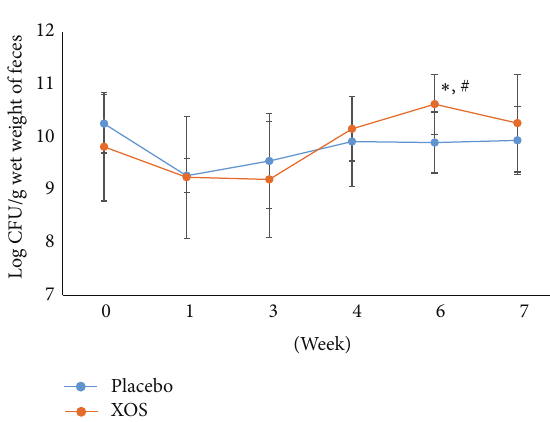
Figure 4: The changes in logarithm number (mean ± SD) of Bifidobacterium spp . during the trial. Weeks 0-1: a run-in phase. Weeks 6-7: a 1-week washout phase. # Repeated measures ANOVA on different groups across time. ∗ Paired t -test of week 6 versus week 0 within a group. 𝑝 < 0.05 .